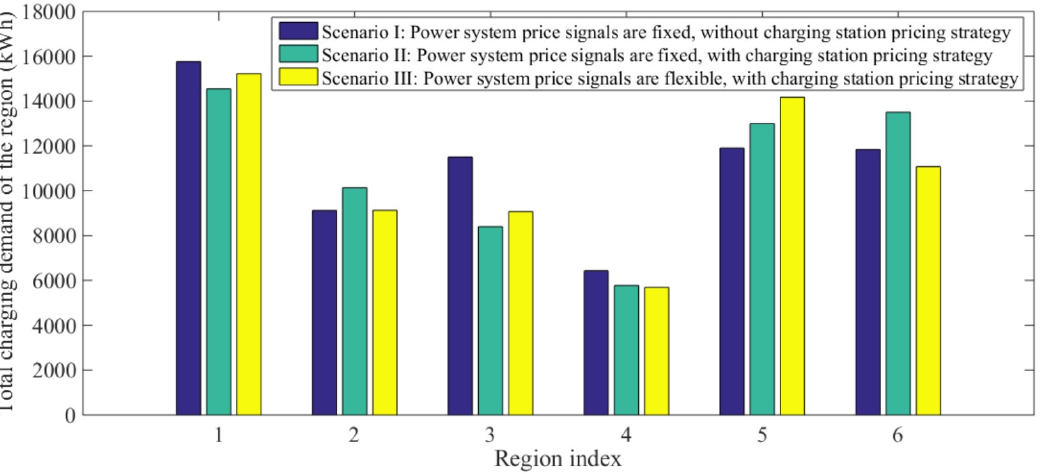
Figure 16. Total charging cost and total power system cost for one hour in the absence of PHEVs (we only consider battery-only EVs in this case study).